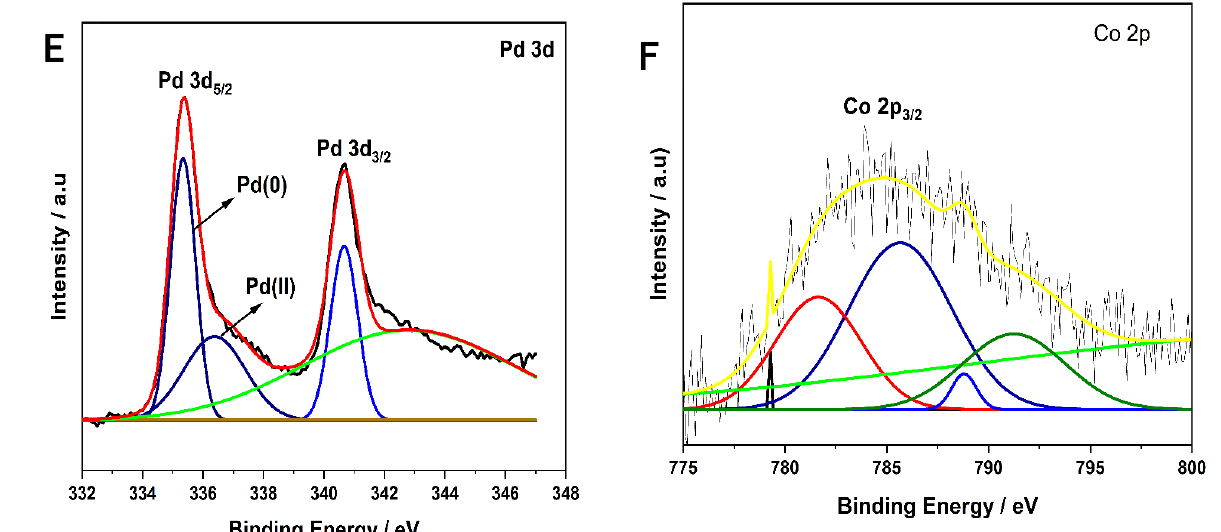
Figure 4. X-ray photoelectron spectroscopy spectra for Pd 1 Co 1 /N-rGO catalyst ( A ) overall spectra, ( B ) C1s, ( C ) O1s ( D ) N1s, ( E ) Pd, ( F ) Co2p.